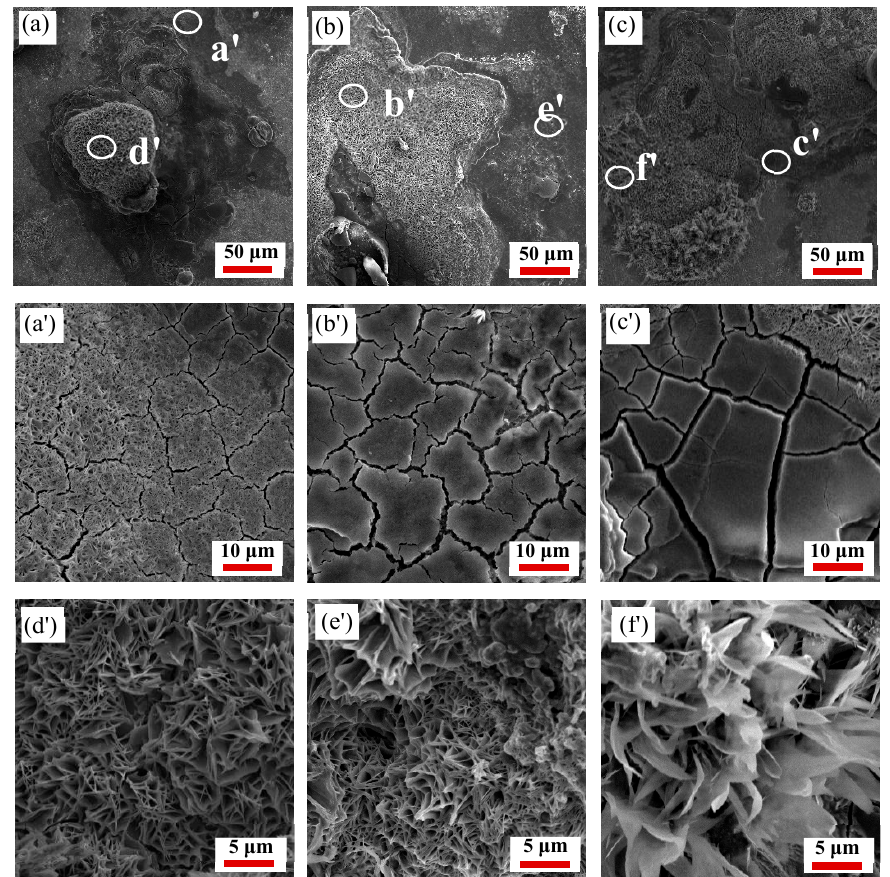
Figure 12. Scanning electron microscopy (SEM) corrosion morphology of the 35CrMoV steel: ( a ), ( a ' ), ( d ' ) 0.01 s − 1 , 850 °C; ( b ), ( b ' ), ( e ' ) 0.01 s − 1 , 950 °C; and ( c ), ( c ' ), ( f ' ) 0.01 s − 1 , 1050 °C.